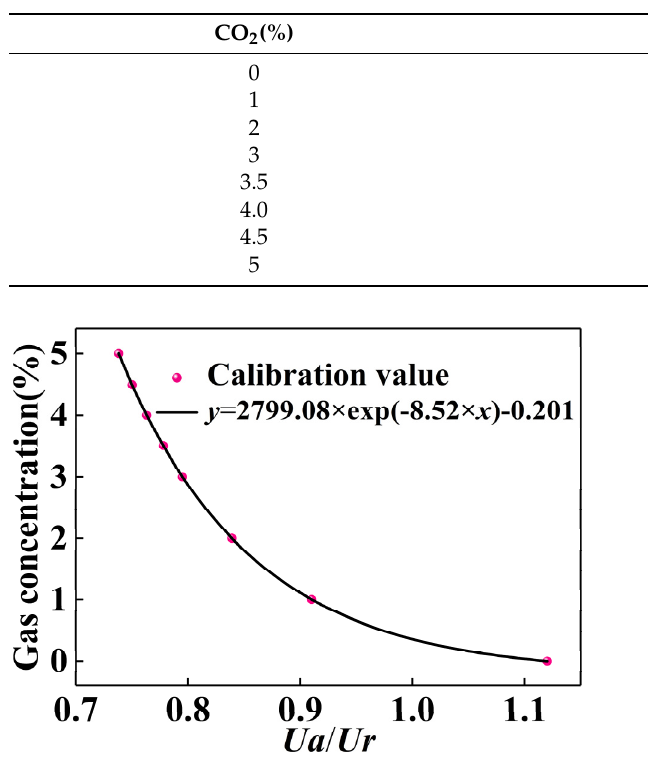
Figure 5. Fitting relationship between gas concentration and voltage ratio.